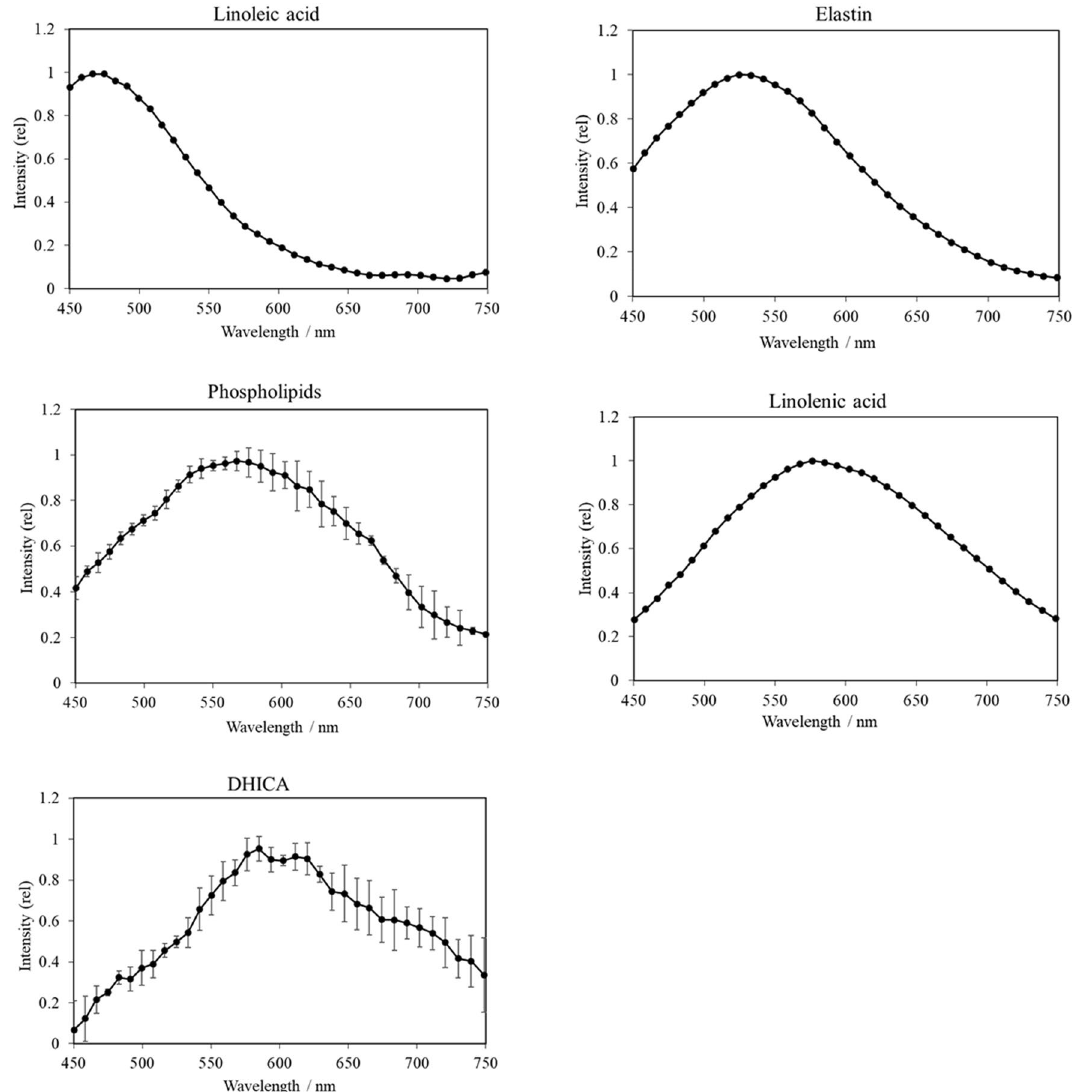
Figure 2. UVA-induced UPE spectra of biomolecules in the skin. Samples were irradiated with UVA (1100 mJ/ cm 2 ) and UPE spectra were measured using a spectroscopy system. UPE intensities were normalized by the intensity at the peak wavelength and are displayed as the relative intensity (rel). Data are presented as means ± SD (n = 4 phospholipids and DHICA). Spectra of raw materials were measured for all biomolecules except for DHICA, for which a 1 mM solution was used for measurement.